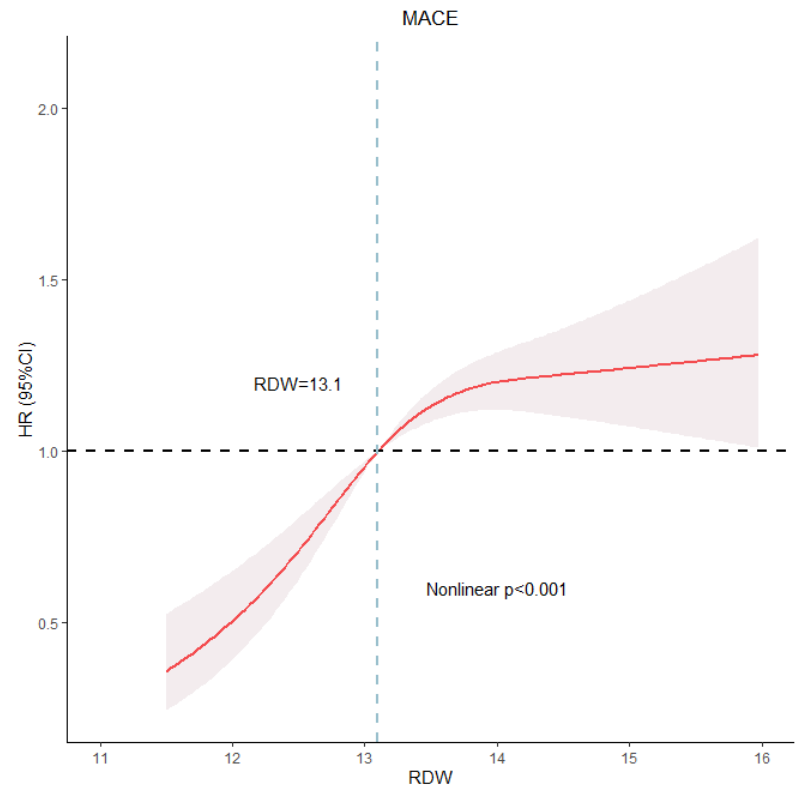
Figure 3. RCS model showing the association between the RDW and MACE. Abbreviations: RCS: restricted cubic spline; RDW: red blood cell distribution width; MACE: major adverse cardiovascular events; HR: hazards ratio; CI: confidence interval. Table 4. Subgroup analysis of associations between RDW and